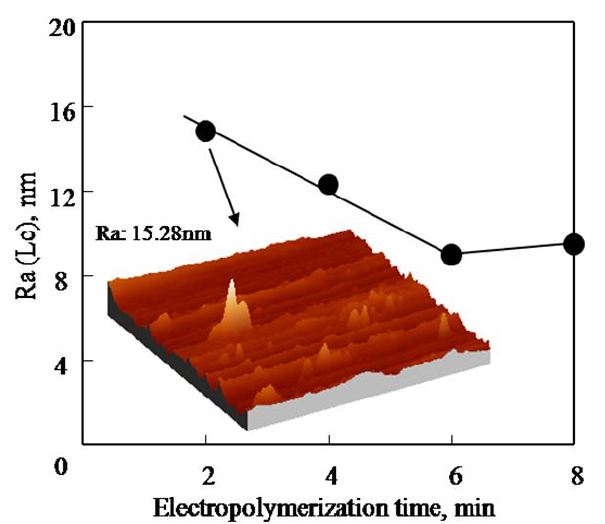
Figure 4. Effect of electropolymerization time on the three-dimensional morphology of PAF17